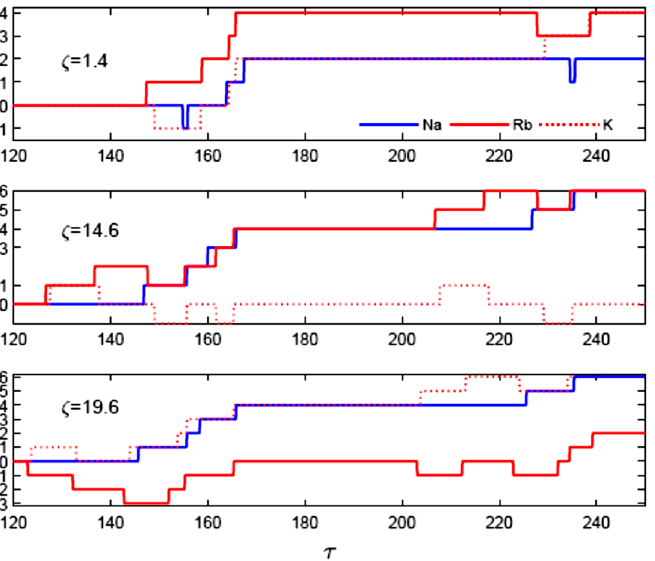
Figure 9. The drive pulses’ relative phase with various prolonged spaces and expressed in π units. (weak field’s case).